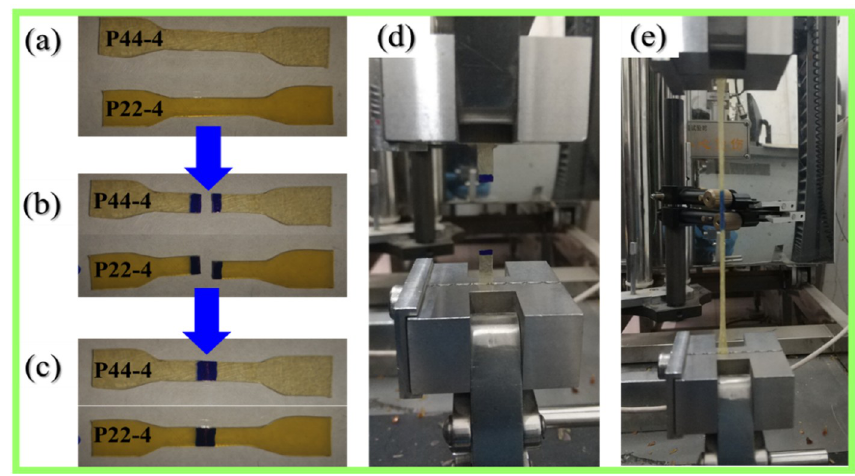
Figure 7. Photos of the self-healing process: ( a ) the pristine P44-4 and P22-4 film samples; ( b ) the films after complete cutting; ( c ) the healed films after 4 h at 50 °C; ( d ) the tensile test of the healed P44-4; ( e ) the tensile test of the healed P22-4.